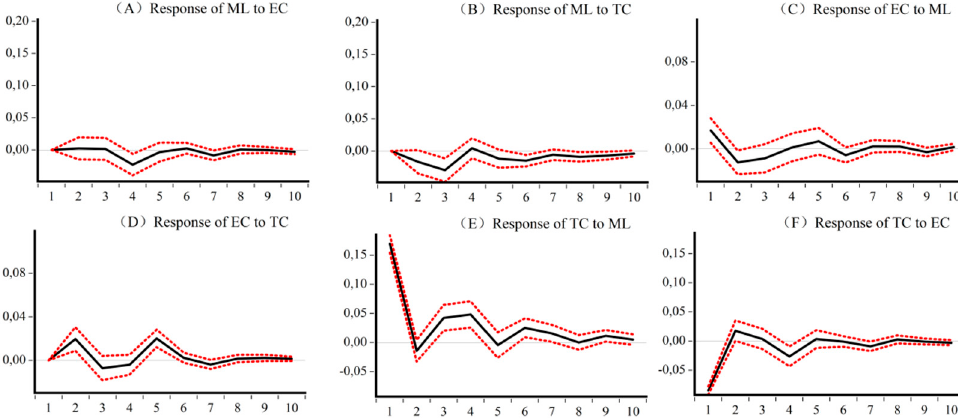
Figure 5. Impulse response results of ML , EC , and TC of National CEE. ( A ) Response of ML to EC ( B ) Response of ML to TC ( C ) Response of EC to ML ( D ) Response of EC to TC ( E ) Response of TC to ML ( F ) Response of TC to EC.